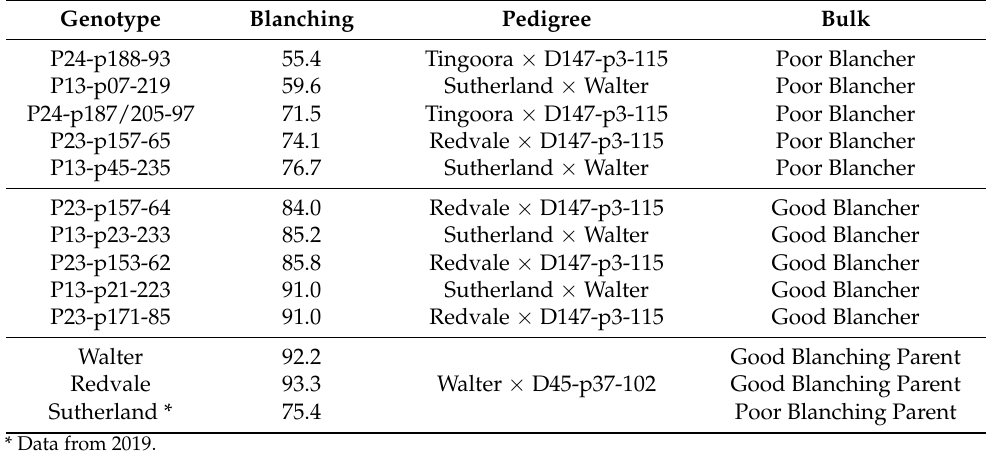
Table 1. Phenotypes for selected lines for bulk sequencing.